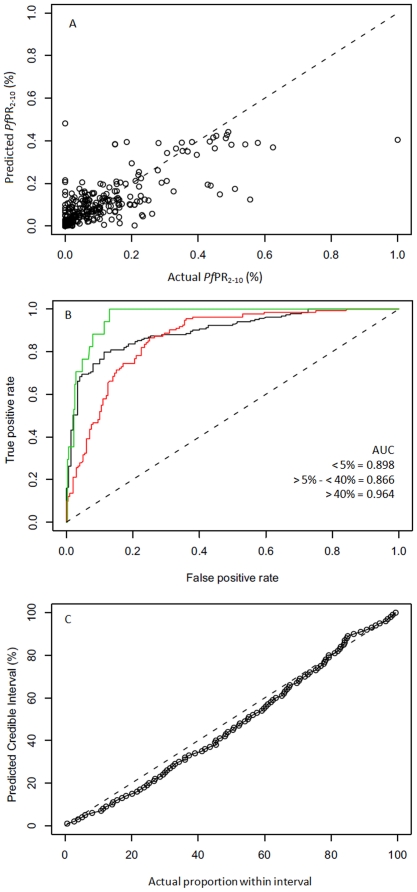
Evaluation of model performance.(A) Scatter plot of actual versus predicted point-values of PfPR2–10. (B) Receiver-Operating-Characteristic curves for each PfPR2–10 endemicity class (PfPR2–10<5%; 5%<PfPR2–10<40%; PfPR2–10≥40%) and associated AUC statistics. (C) Probability-probability plot comparing predicted credible intervals with the actual percentage of true values lying inside those intervals. In the top and bottom plots the 1∶1 line is also shown (dashed line) for reference.